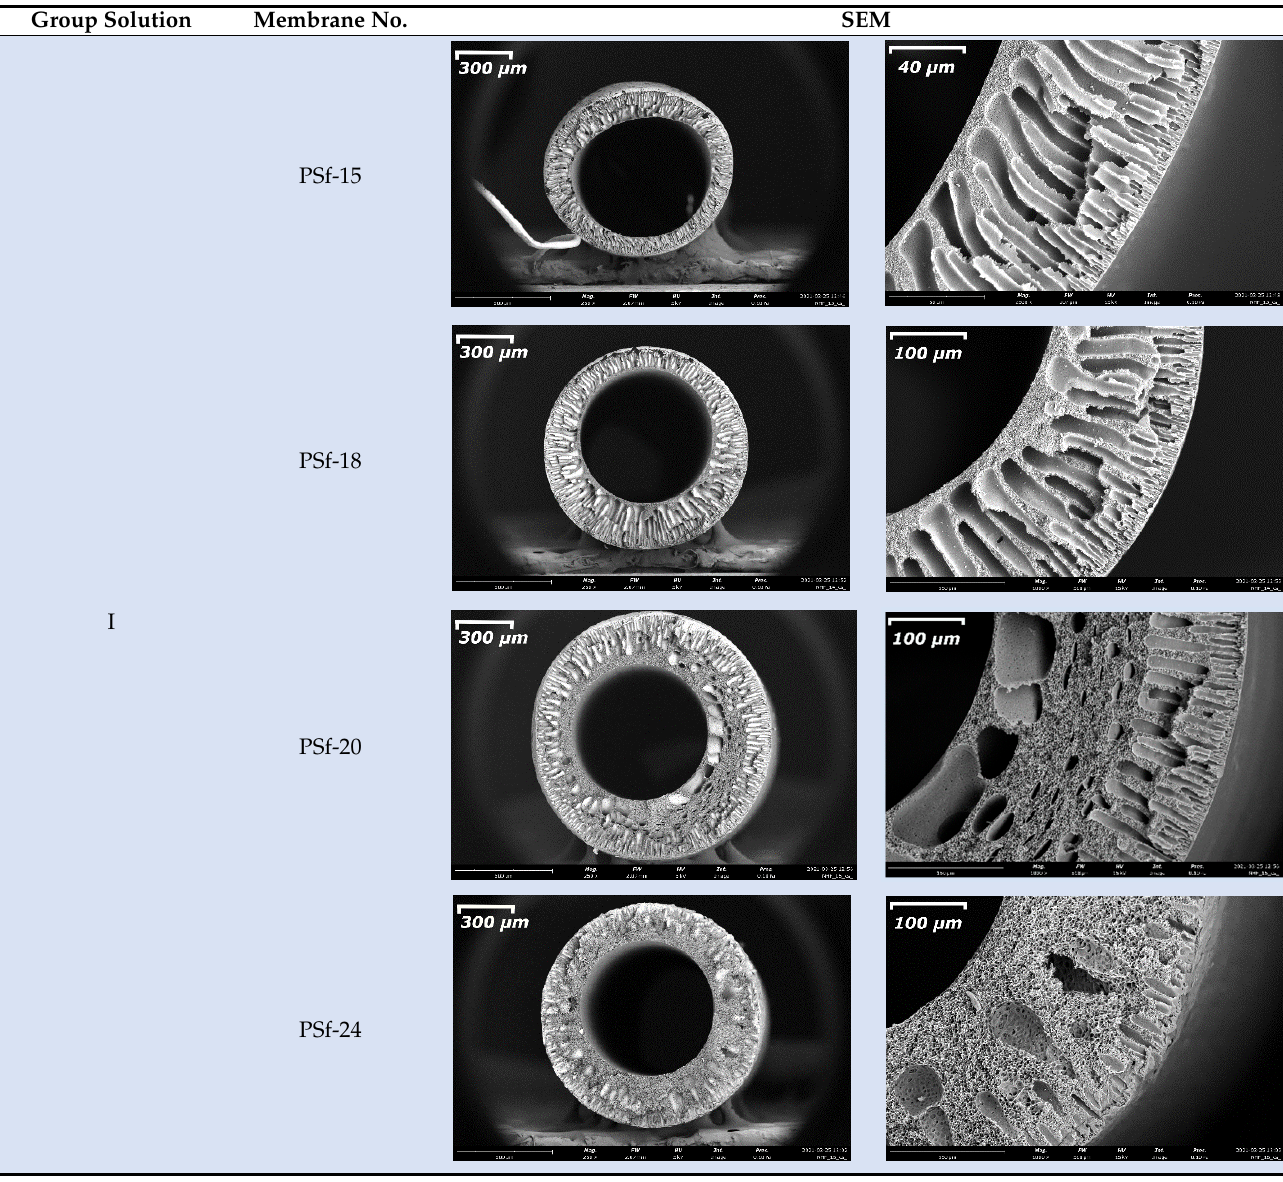
Table 4. Scanning electron microscopy (SEM) photographs of hollow fiber membranes made from polymer solutions. I—